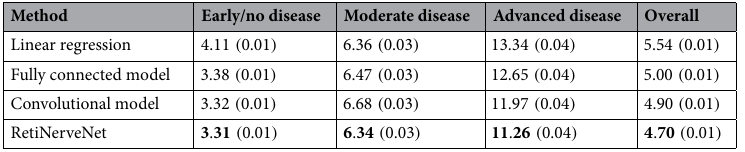
Table 2. Average MAE (with standard errors) for visual field prediction based on RNFL thickness. Best results in boldface.